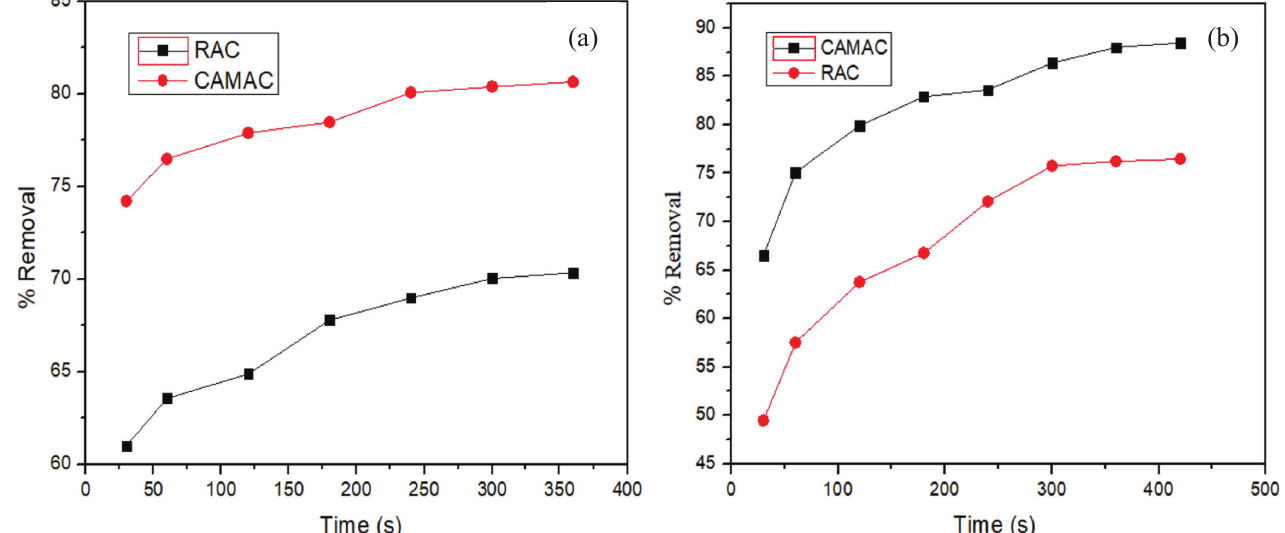
Fig. 8 – Effect of time on adsorption of As(III) (a) and for Cu(II) (b) onto RAC and